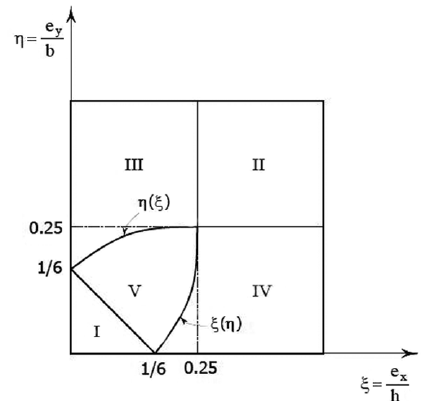
Fig. 4. Five different zones corresponding to five cases for the determination of K rx , K